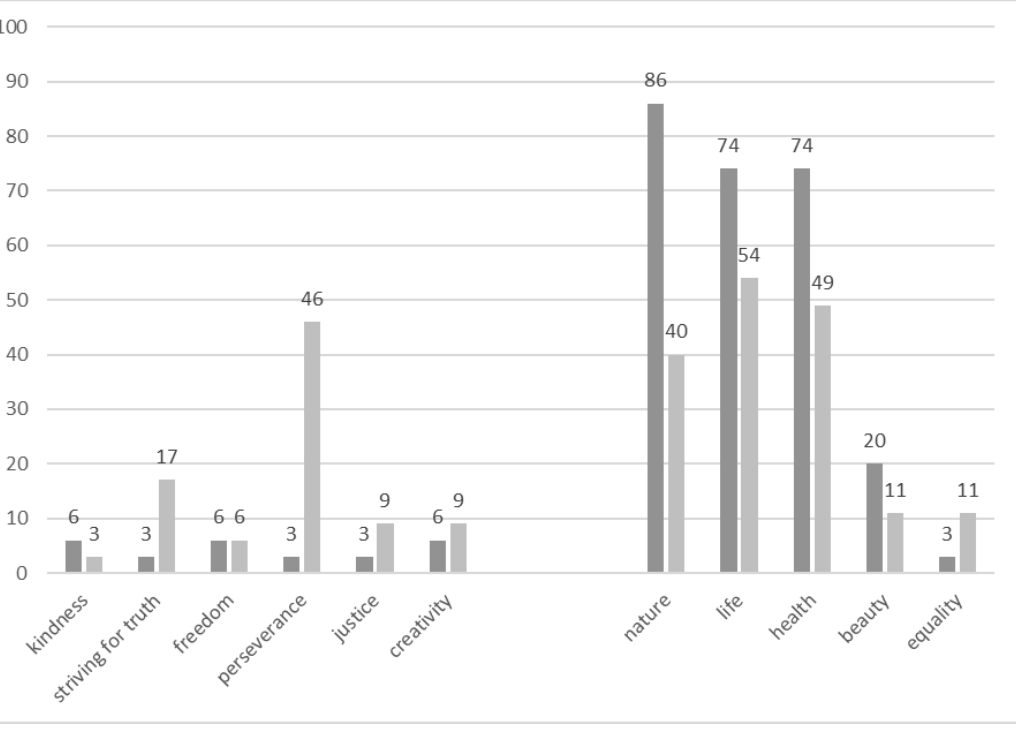
Figure 57: Presentation of paper